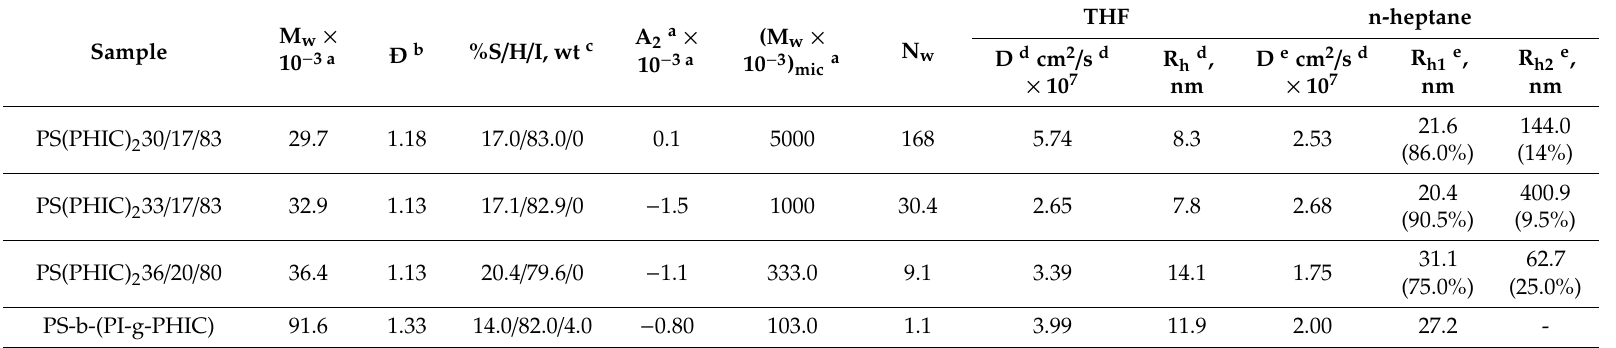
Table 7. Molecular characteristics of the PS(PHIC) 2 miktoarm star copolymers and the PS-b-(PI-g-PHIC)block graft terpolymer and their micellar characteristics in